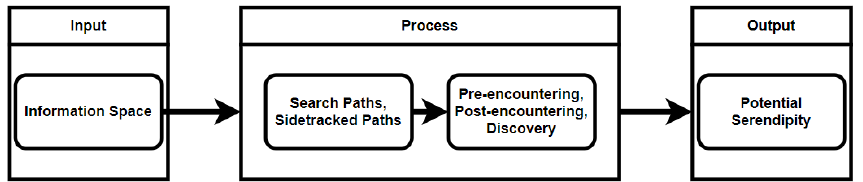
Figure 6. Three phases of the serendipity evaluation model.